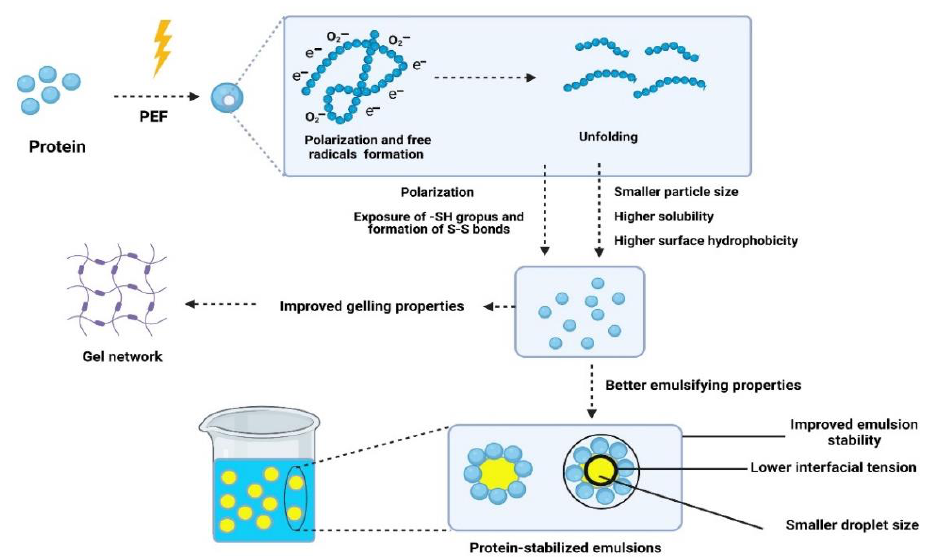
Figure 7. Proposed mechanism of PEF effects on the emulsifying and gelling properties of proteins. This figure was created with BioRender.com, (accessed on 18 May 2022) with publication permis- sion.